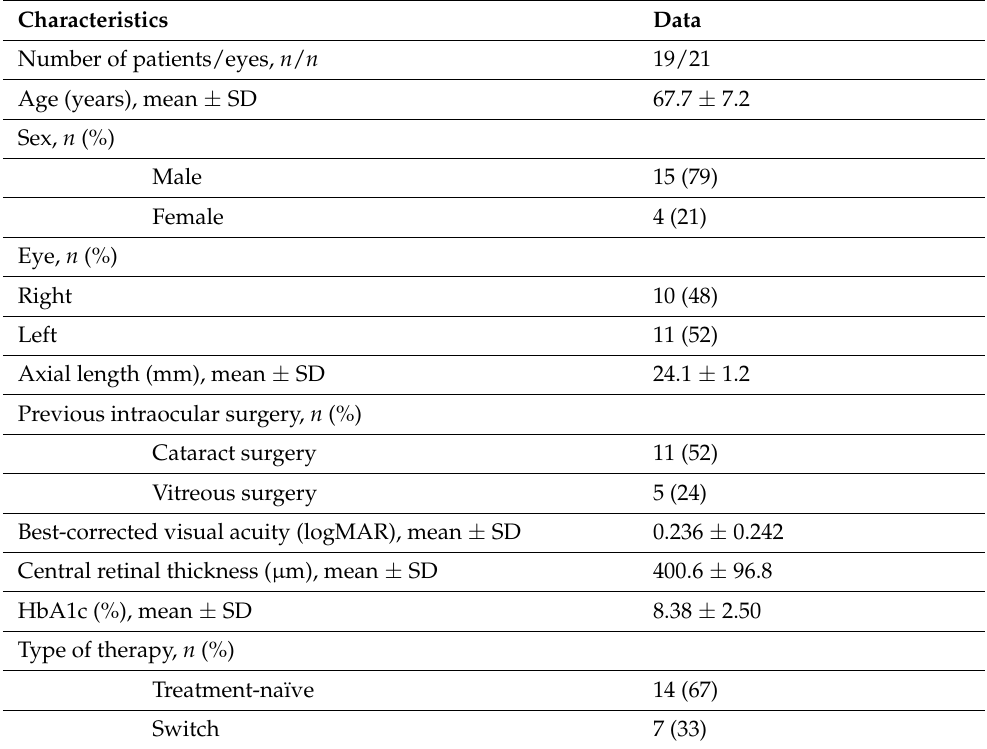
Table 1. Patients’ characteristics at baseline.